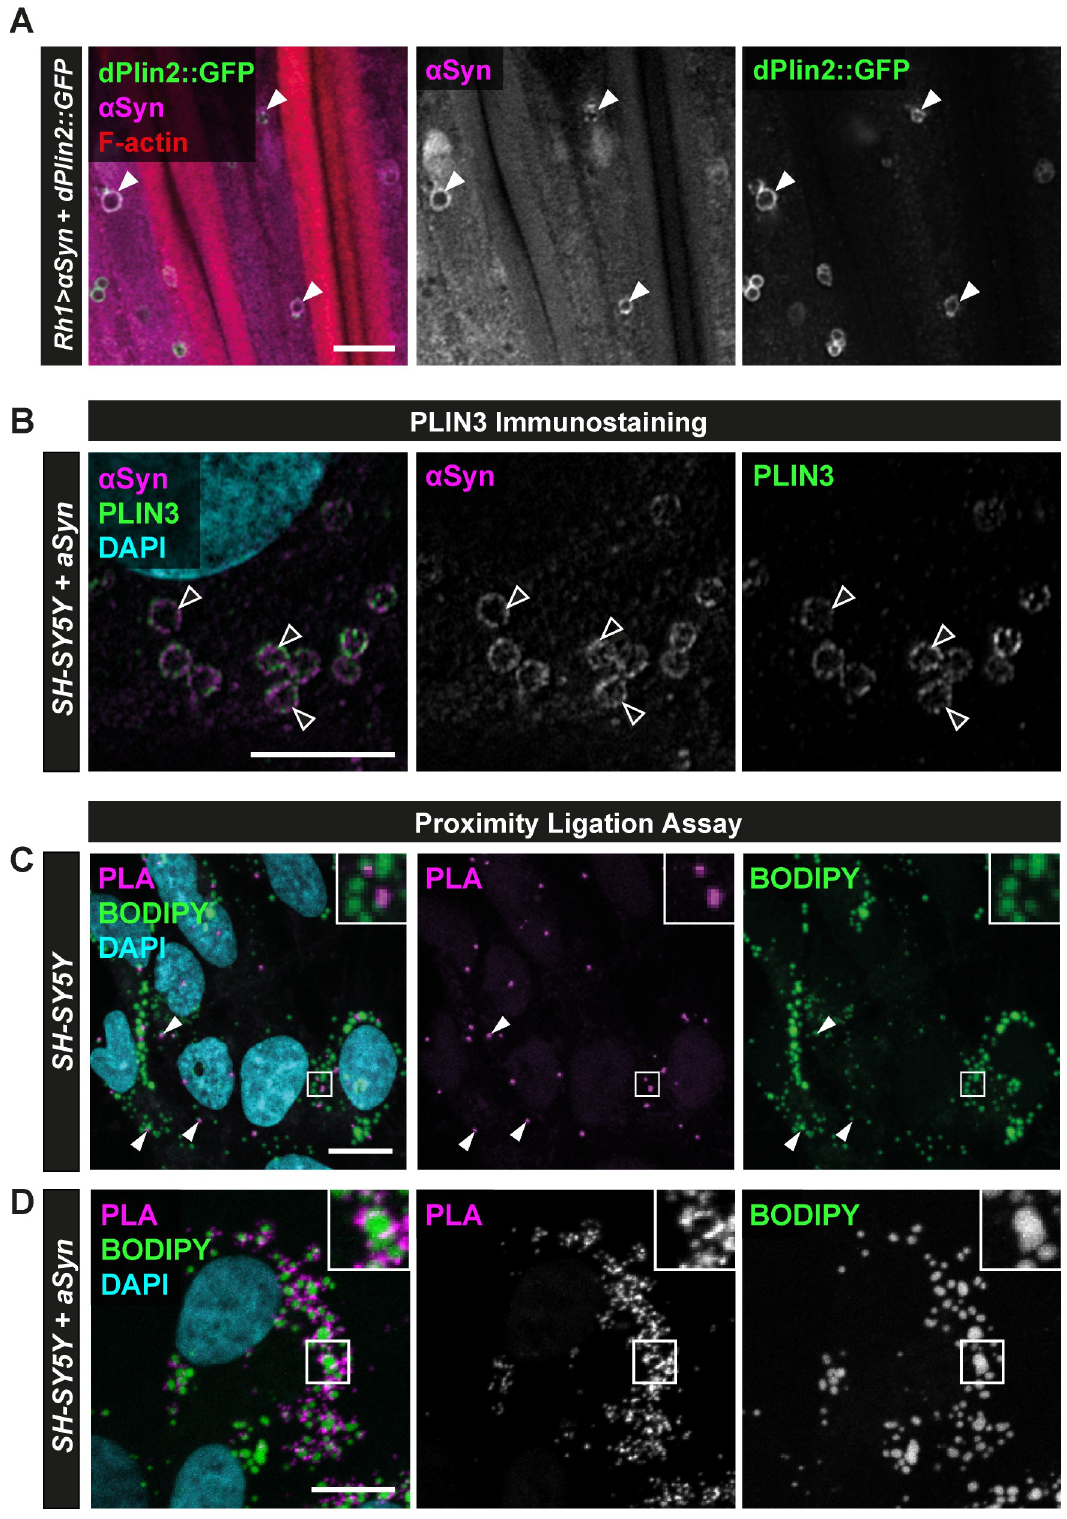
Fig 4. α Syn co-localizes with PLINs at the surface of LDs in Drosophila photoreceptor neurons and in human neuroblastoma cells. (A) Immunostaining of whole-mount retinas from flies expressing α Syn and dPlin2::GFP in photoreceptor neurons ( Rh1-GAL4 ). α Syn is in magenta (anti- α Syn) and photoreceptor rhabdomeres are in red (phalloidin-rhodamine). White